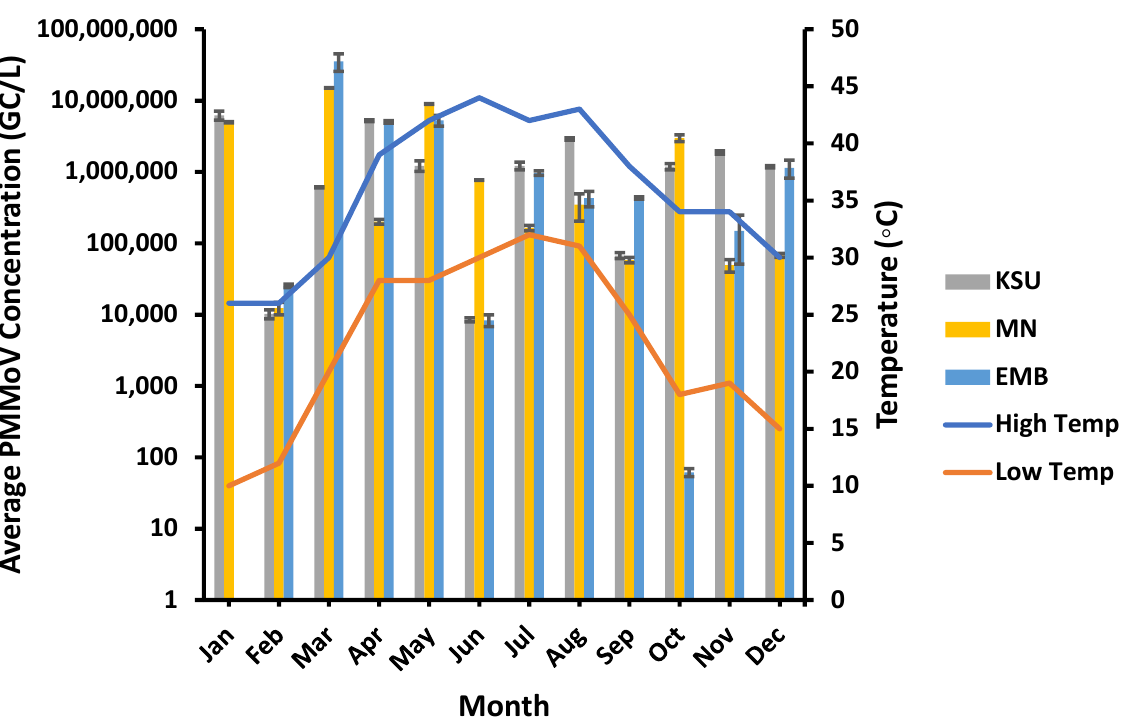
Figure 2. Seasonal influence on PMMoV concentration.